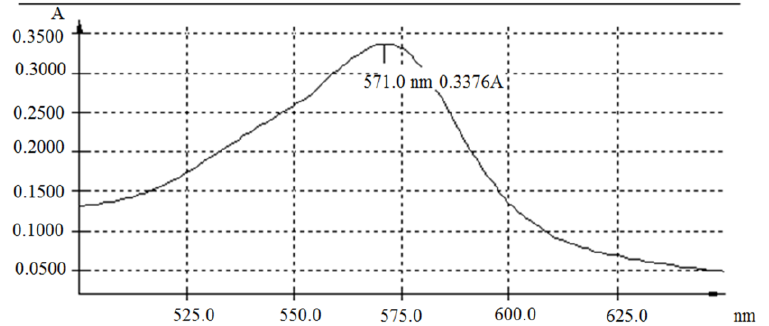
Fig. 10. Fructose spectrum with α-naphthol and additives (urea 3 mg/ml and boric acid 6 mg/ml) in the inulin complex after hydrolysis for 15